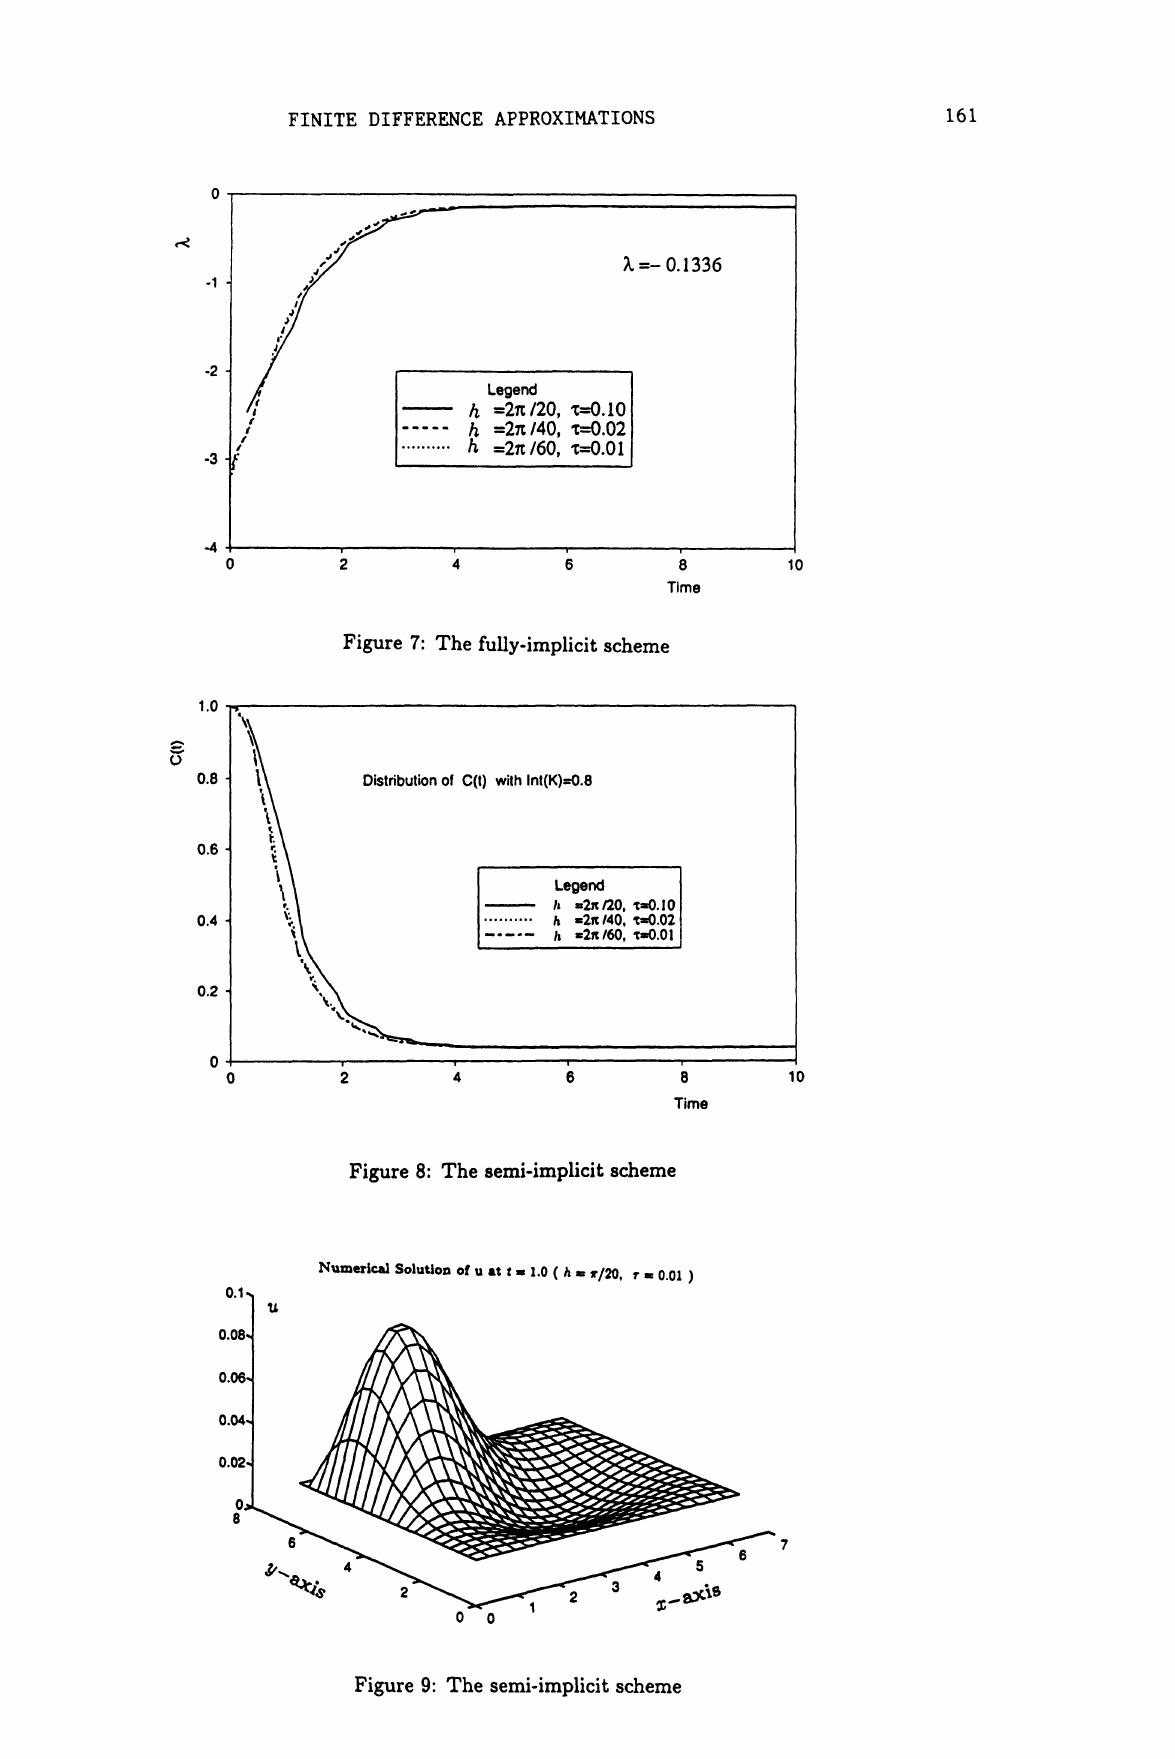
Figure 8: The semi-implicit scheme